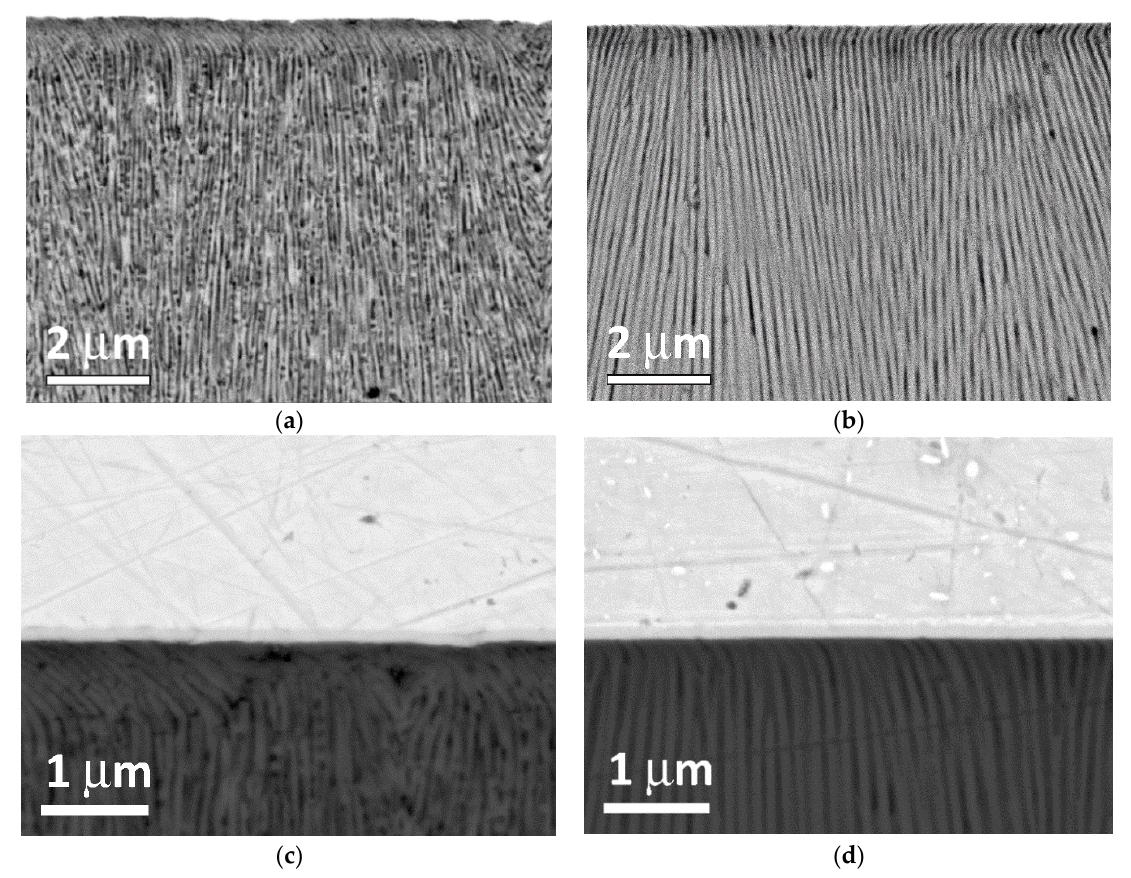
Figure 5. ( a , с ) Cross-section view of polished AA#1. ( b,d ) Cross-section view of polished AA#2. Figure 5. ( a , c ) Cross-section view of polished AA#1. ( b,d ) Cross-section view of polished